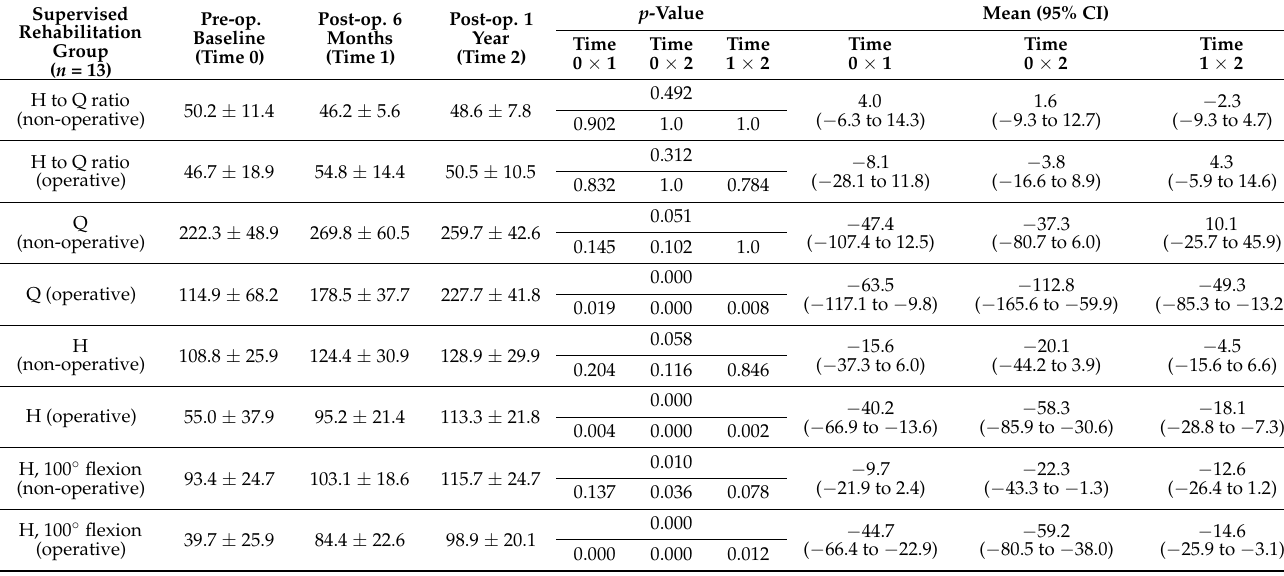
Table 2. Serial changes in muscle ratio and strength of quadriceps and hamstring of enrolled subjects in the supervised rehabilitation group.